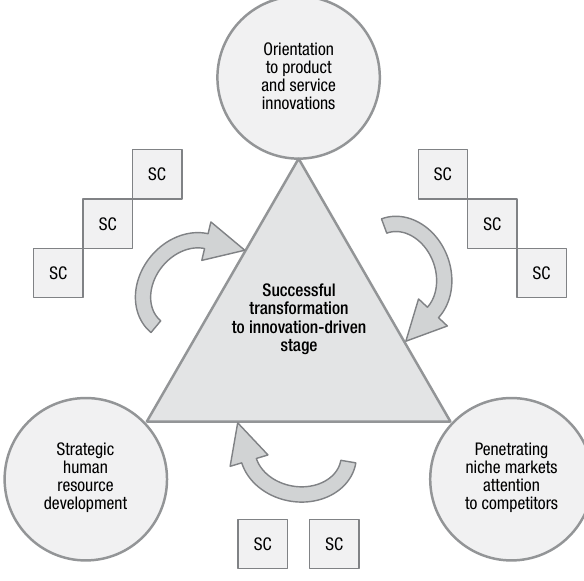
Fig. 2. Conditions for a successful transformation to the innovation-driven stage, SC refer to social capital Source: prepared by authors, based on GEM, Lithuania